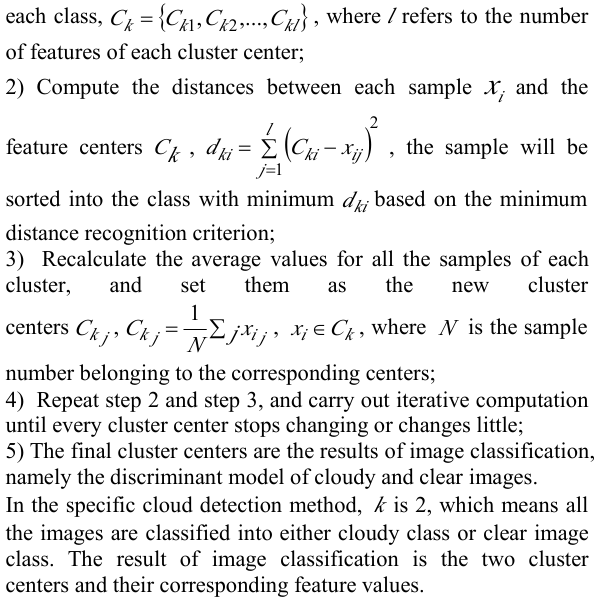
4444 ） FFFFractalractalractalractal dimensiondimensiondimensiondimension Fractal dimension is used to measure the irregular degree